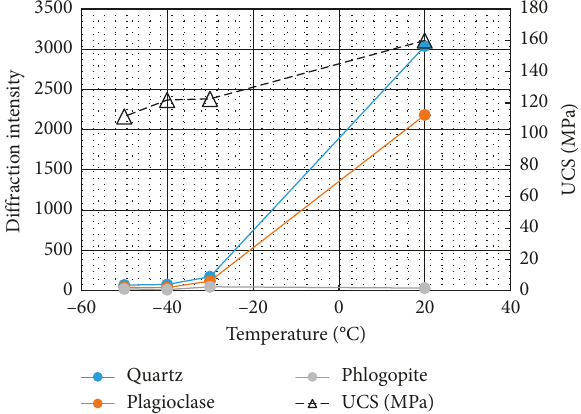
Figure 10: The relationship between the diffraction intensity of minerals and the UCS of tonalite specimens.